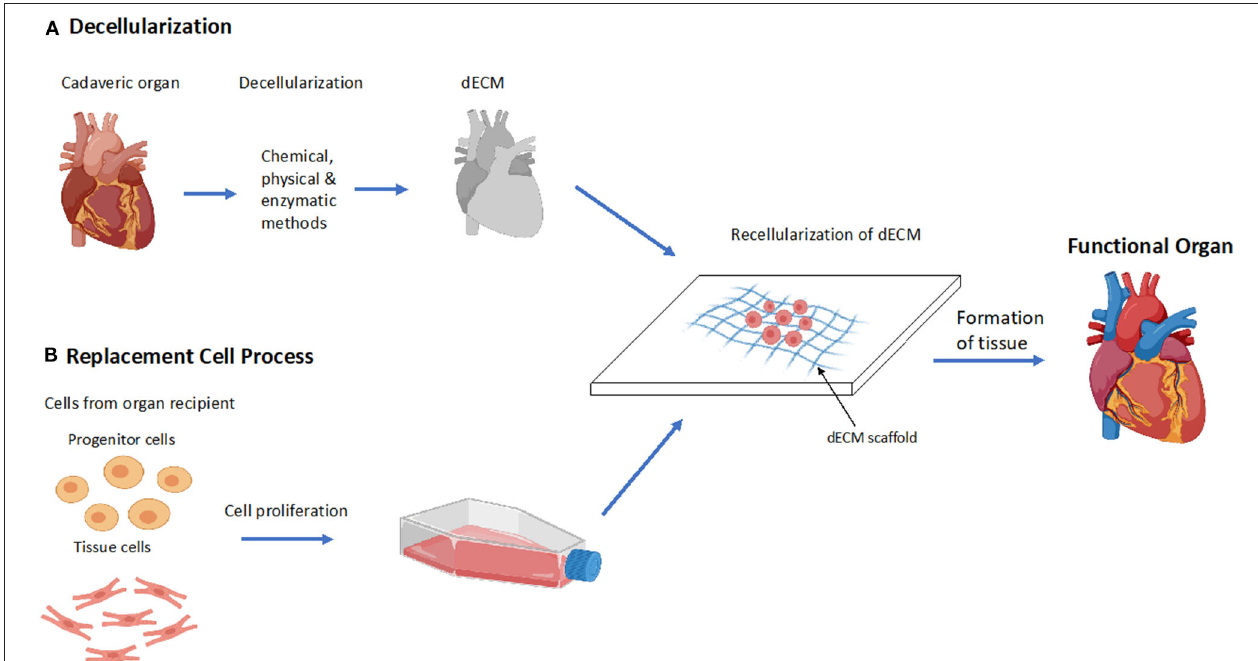
FIGURE 2 | Decellularization process to form a functional organ. (A) Overview of the process of decellularization of a cadaveric heart to a functional heart. Decellularization of cadaveric organs followed by the recellularization of the dECM scaffold which forms functional tissue. (B) Overview of the stage’s replacement cells undergo during the process of recellularization. Cells are extracted from the recipient of the organ and are cultured and proliferated, then inserted into the dECM where it forms a functional